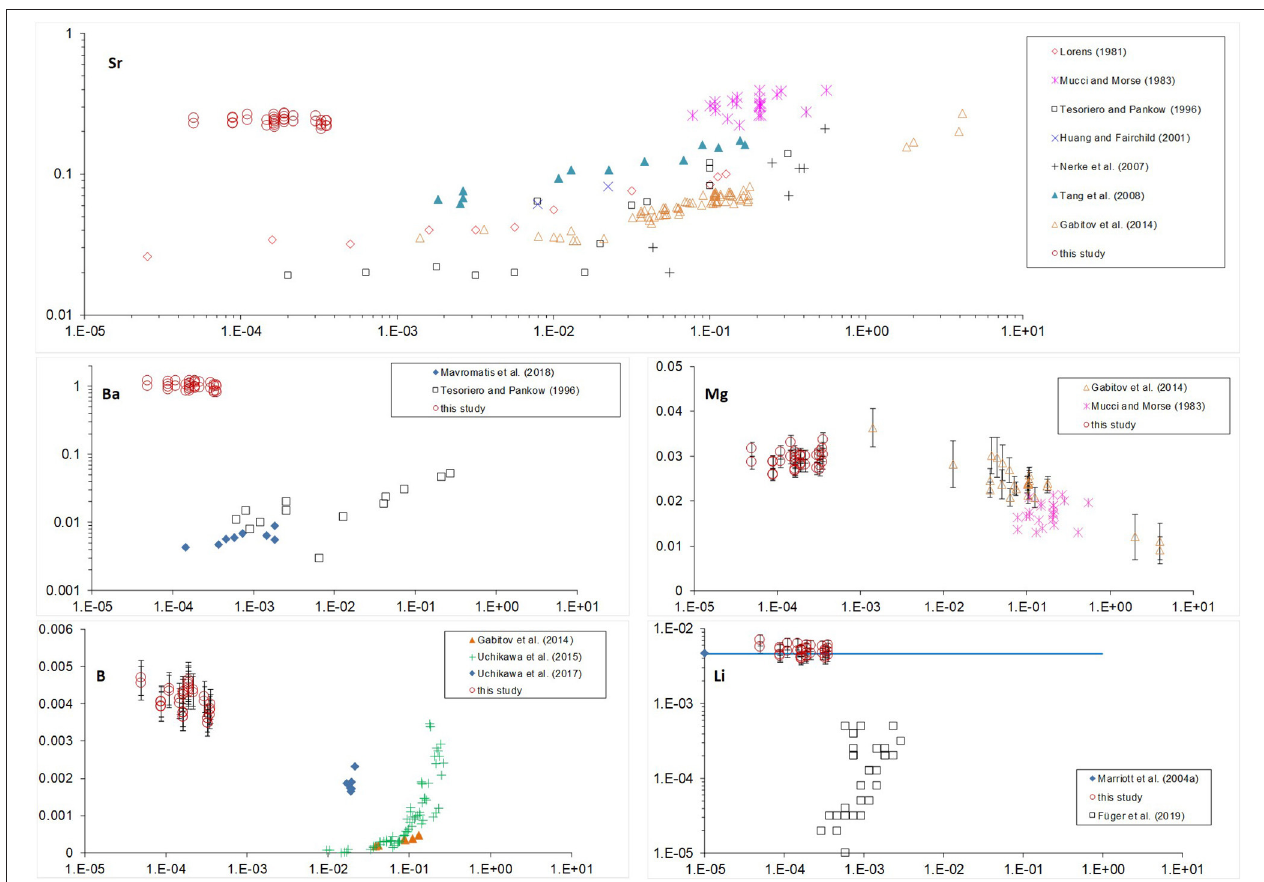
FIGURE 4 | Partition coefficients of Sr, Ba, Mg, B, and Li vs. crystal growth rate. Standard error bars of our data are not presented on the plot if smaller than size of the